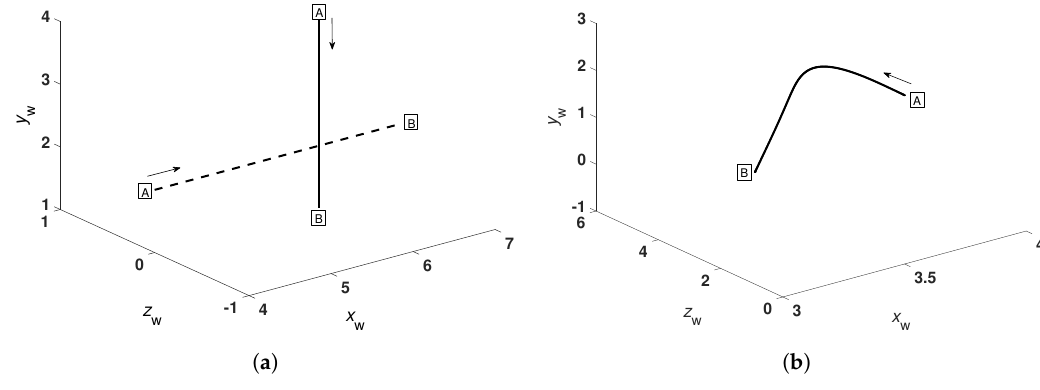
Figure 9. Test paths: ( a ) Horizontal and vertical paths; and ( b ) return half of log-loading cycle. The paths were driven three times using each redundancy resolution from (1) through (8), and the results were averaged. Two initial configurations of the manipulator at the beginning of each path were also considered: firstly, based on the smallest feasible extension cylinder length and subsequently based on the middle point between the smallest and largest feasible extension cylinder lengths. The supply pressure of the CP system was set to 20 MPa in the experiments, and the motion controller used is discussed in Appendix